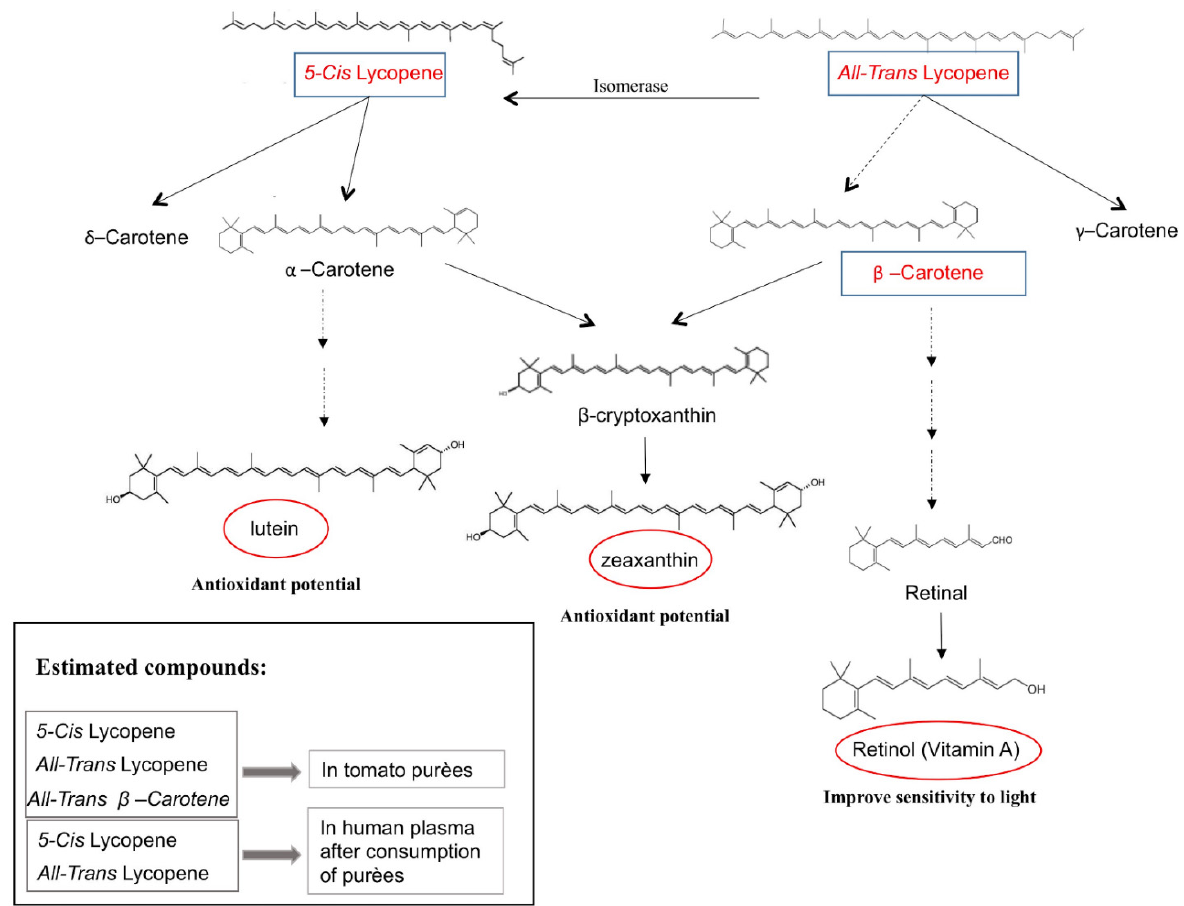
Figure 5. The biosynthesis pathway of carotenoids in humans. Solid and dashed arrows represent single and multiple enzymatic steps, respectively. The question mark indicates reactions not yet completely understood in humans. The estimated compounds are enclosed in rectangles while derivative final compounds for their beneficial effects in humans are in red oval circles.